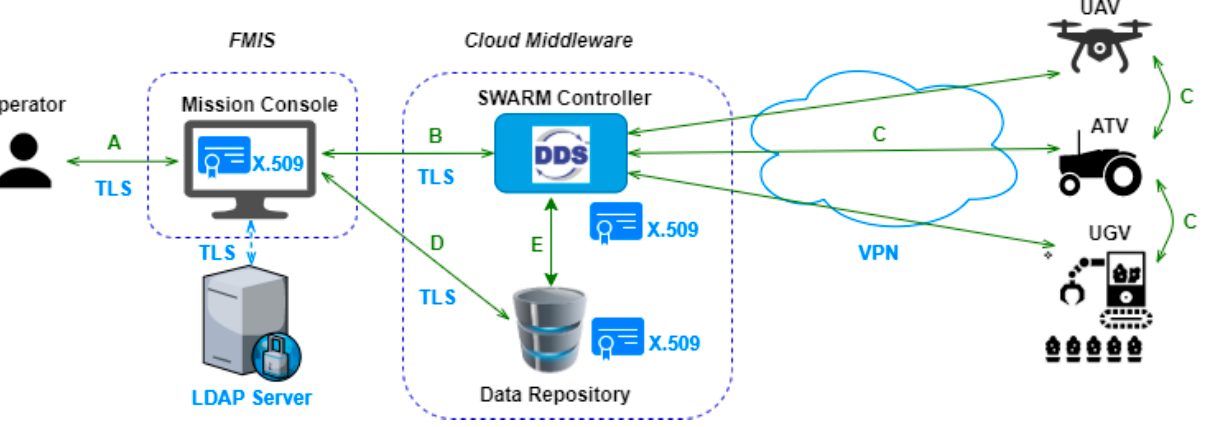
Figure 2. Security solution for a system to manage missions with swarms of autonomous vehicles.